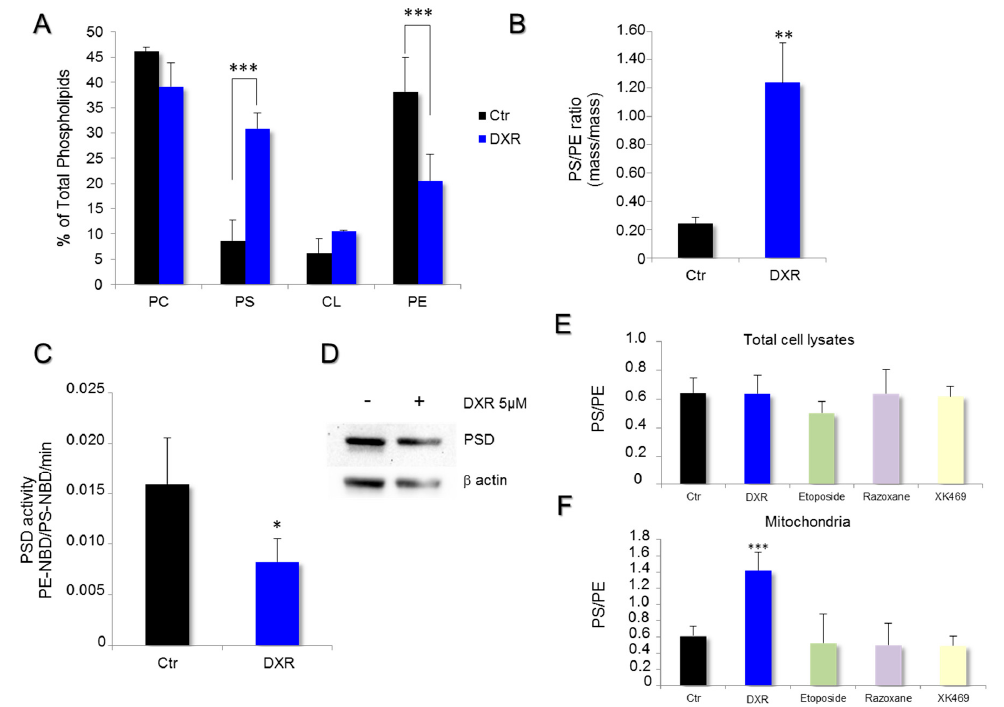
Figure 2. DXR modifies mitochondrial membrane composition of HeLa cells while inhibiting phosphatidylserine decarboxylase (PSD) activity. The effect of DXR on the phospholipid composition of mitochondrial membranes was analyzed by high-performance thin-layer chromatography. ( A ) The quantification of PC, phosphatidylcholine; PS, phosphatidylserine; CL, cardiolipin; and PE, phosphatidylethanolamine was performed by densitometry and expressed as a percentage of total phospholipids. The mitochondrial membrane composition obtained after 5 µM DXR treatment was compared to that in control conditions. ***, P < 0.001; Multiple t test of two-way ANOVA. ( B ) The PS/PE ratio was determined in HeLa cells, treated or untreated, with DXR at 5 µM (**, P < 0.01). ( C ) The rate of PSD activity was determined in vitro on isolated mitochondria using a fluorescent analog of phosphatidylserine, PS-NBD (black). The enzyme activity was also measured in the presence of DXR 5 µM (blue). The data are expressed in PE-NBD/PS-NBD ratio per minute. Each point represents the mean value ± SEM of N ≥ 3 experiments (*, P < 0.05). ( D ) The expression level of PSD was analyzed by Western blot on cell lysate treated by 5 µM DXR for 24 h, and compared to the untreated cells. The effect of topoisomerase inhibitors on PS/PE ratios was determined from ( E ) total cell lysates and the ( F ) isolated mitochondrial fraction. Cells were incubated with 5 µM DXR, 1.25 µM etoposide, 20 µM razoxane, or 10 µM XK469 for 24 h. Then, estimation of the PS/PE ratios was performed. The data are expressed as mean values ± SD with ***, P < 0.001.